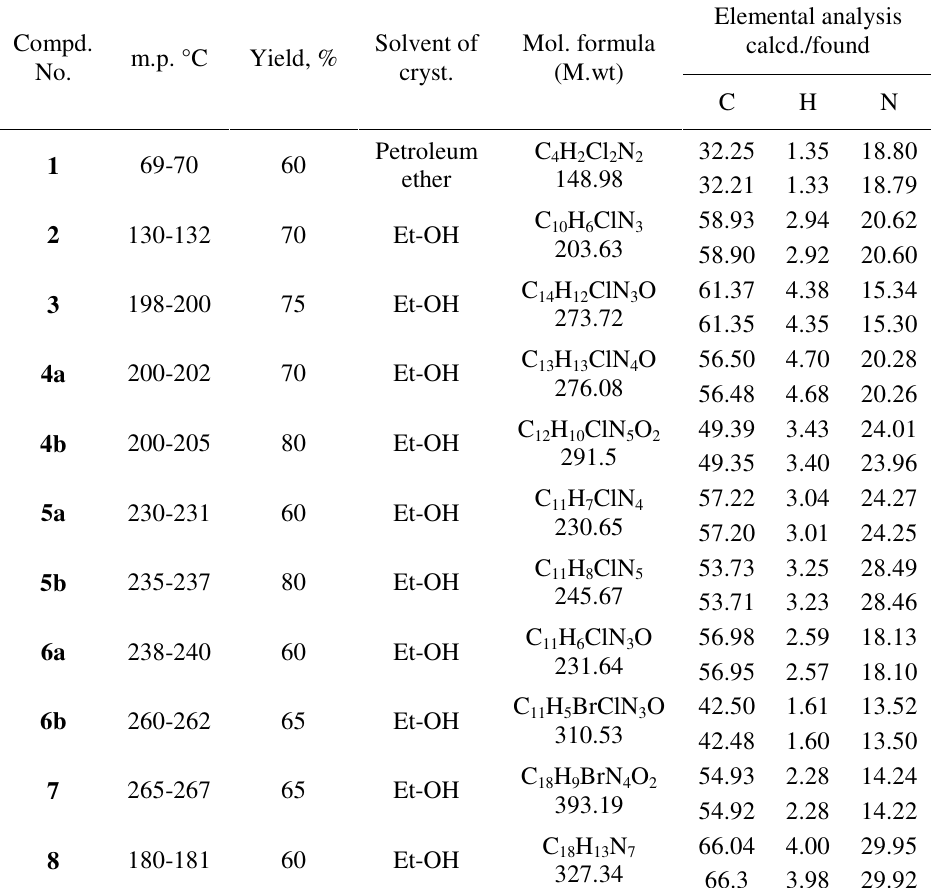
Table 1. Physical properties of the prepared compounds